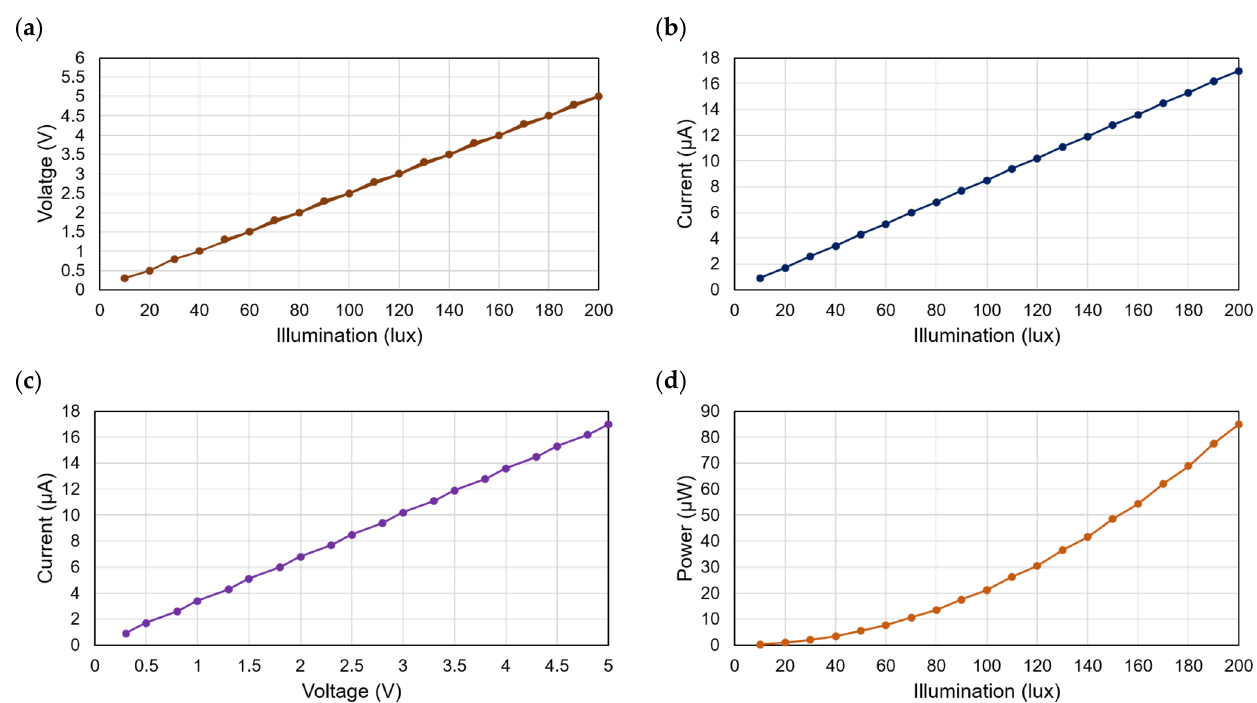
Figure 7. Different characteristics of the AM-1816 PV module; ( a ) illumination vs. voltage; ( b ) illumination vs. current; ( c ) current vs. voltage (I-V); and ( d ) illumination vs. power.